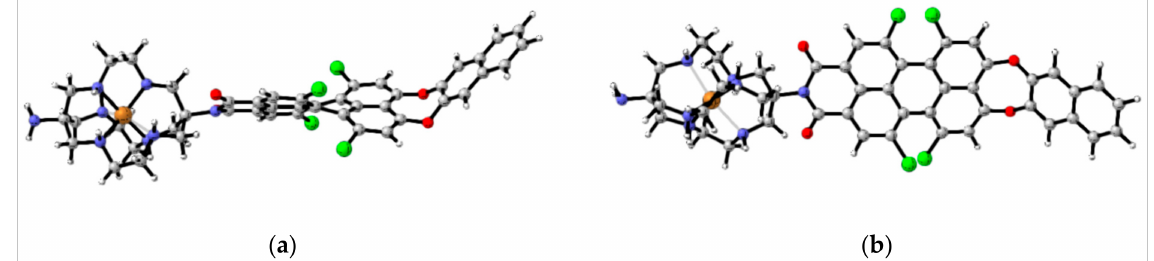
Figure 8. Optimized structure of the complex of 1c with Cu 2+ ions from B3LYP/6-31G(d,p) computa- tions. ( a ) Side view. ( b ) Top view.